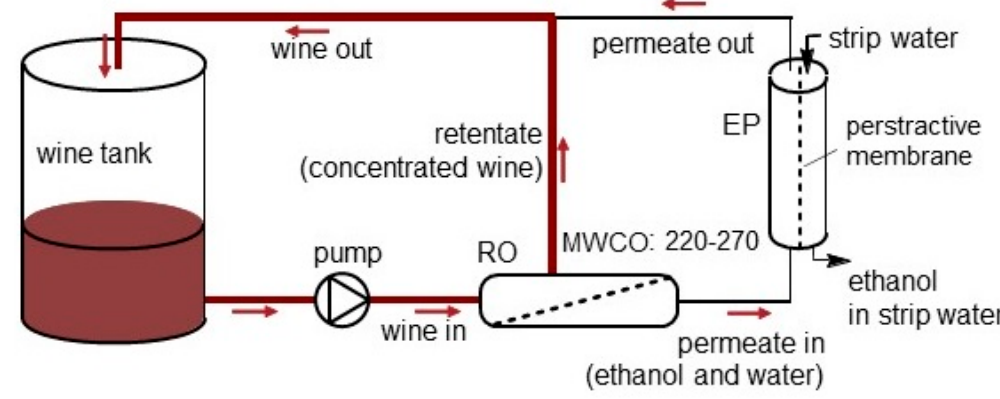
Figure 1. Schematic diagram of the reverse osmosis-evaporative perstraction process.